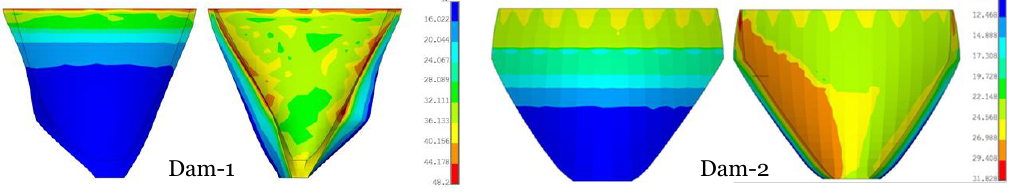
Figure 3. Summer temperature distribution on the dam face resulted from thermal transient